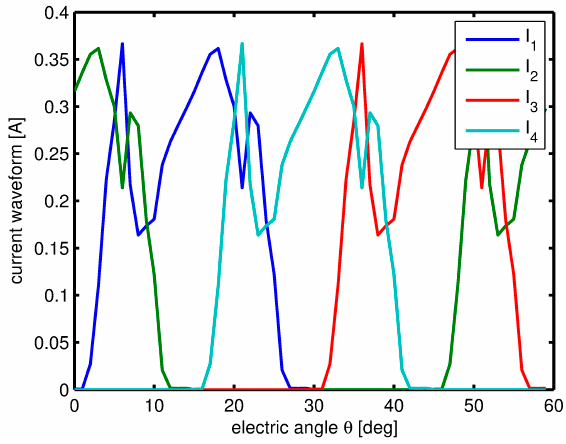
Figure 8. Torque waveform found by optimization.